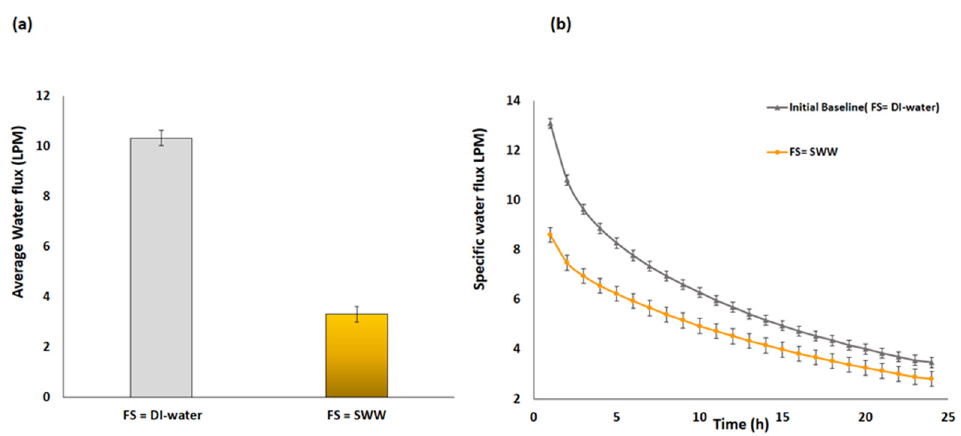
Figure 2. ( a ) Average water flux ( b ) specific water flux. Conditions: feed solution (FS) = SWW, multi-component fertilizer draw solution (MCFDS) (300 g / L) and FS and draw solution (DS) flowrate = 1.6